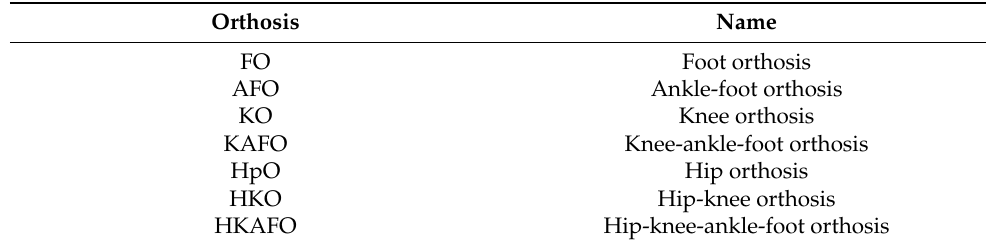
Table 1. Orthoses classification.